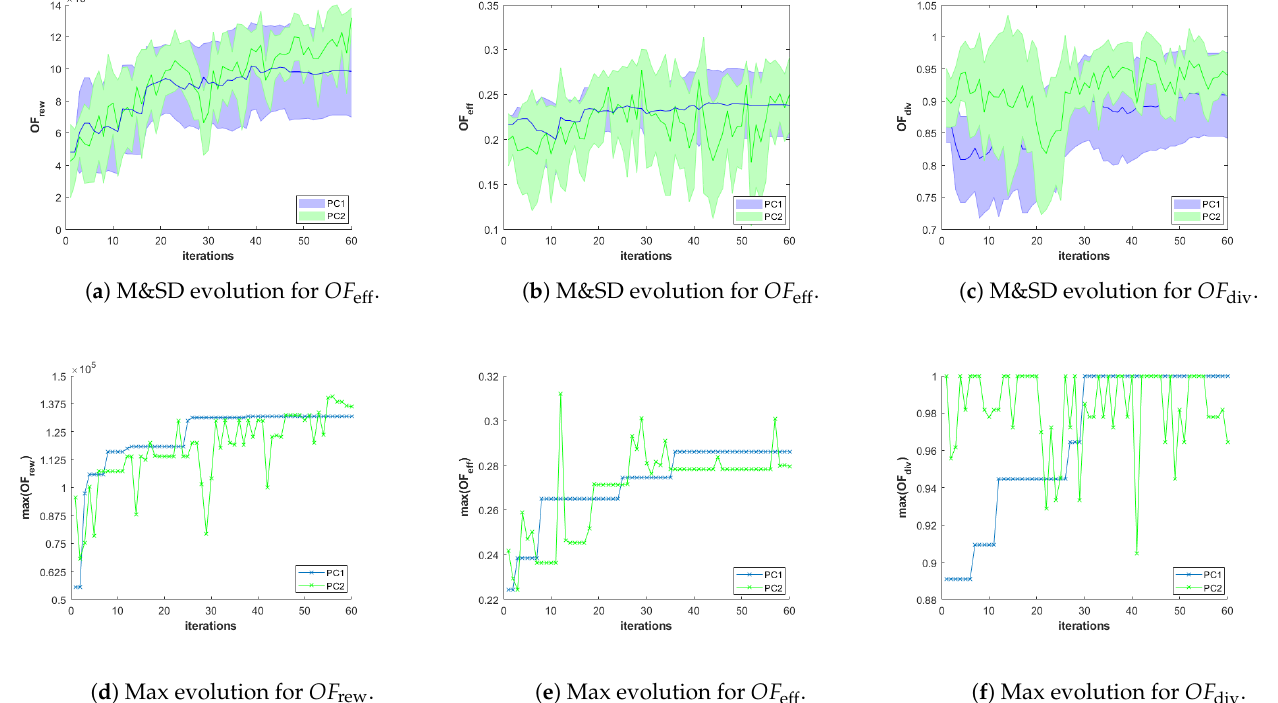
Figure 11. Evolution graphics of the OFs of the feasible solutions of the best Pareto front for SC2. The top row of graphics shows the evolution of the mean and standard deviation (M&SD) of each OF, while the bottom row shows the evolution of the best (Max) value of each